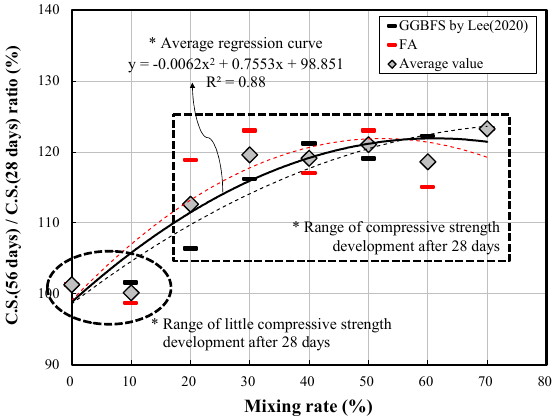
Figure 10. Results of compressive strength (56 days)/compressive strength (28 days) of OPC and FA compared with GGBFS as measured by Lee (adapted from [26]) in terms of the mixing rate.